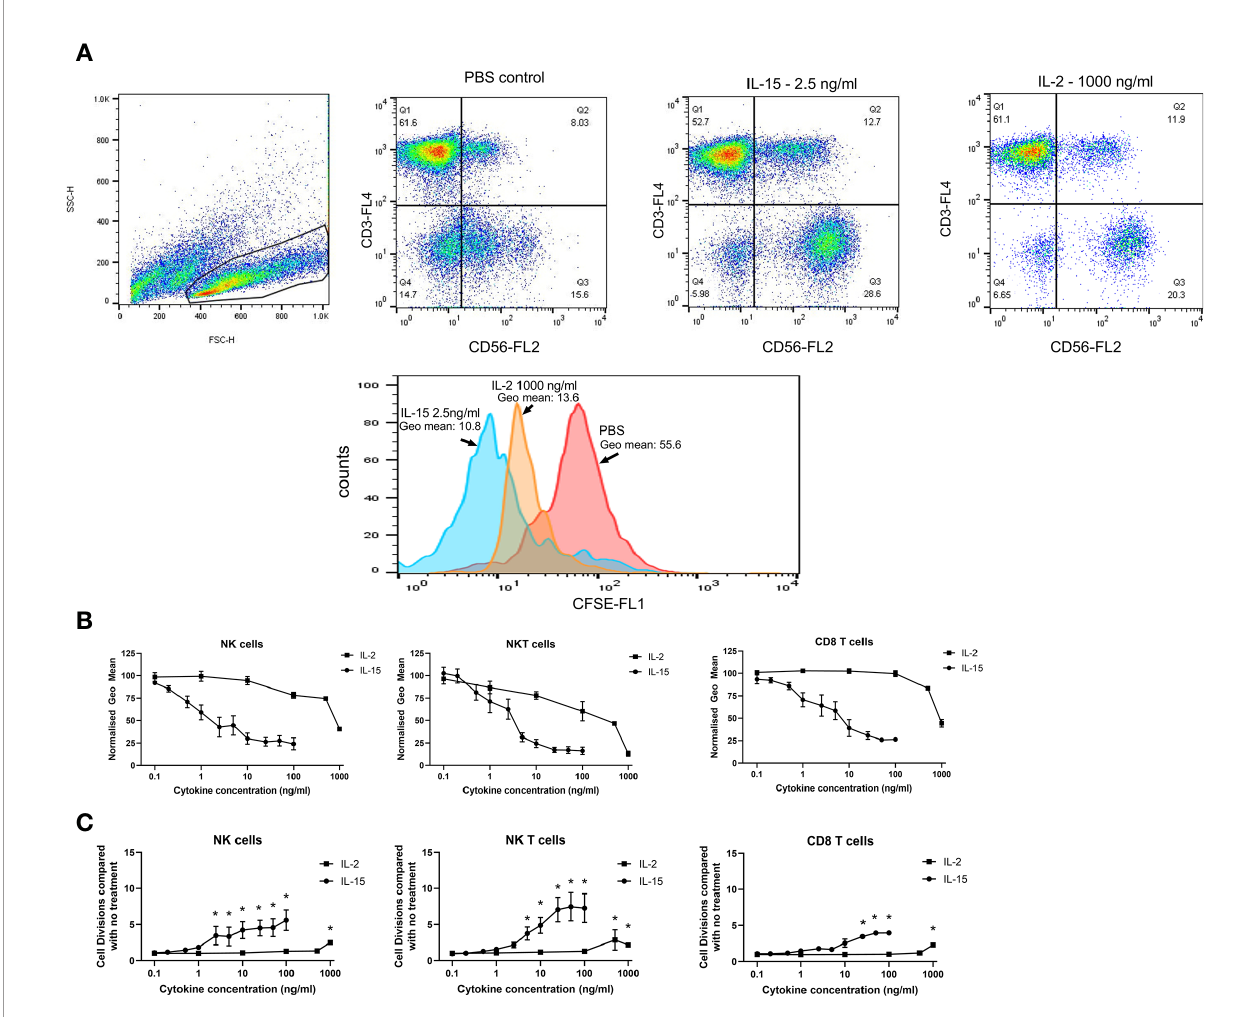
FIGURE 2 | Effects of IL-15 and IL-2 on cell doubling capacity. Non-adherent PBMCs premixed with CFSE were treated for 7 days with concentrations of IL-15 from 0.1 – 100 ng/ml and IL-2 from 0.1 to 1000 ng/ml with PBS as a control. (A) displays the dot plots and a representative histogram showing the representative CFSE staining of a population of CD56+CD3- NK cells in the PBMCs. CFSE staining is measured as the geometric mean of the gated NK cell population and a decrease in the geometric mean signi fi es an increase in cell division. (B) shows the effects of IL-15 and IL-2 on NK, NKT-like and CD8 T cell proliferation as expressed by the normalized geometric mean fl uorescence of CFSE after 7 days. (C) shows the number of cell divisions observed above that of the control cell population (with no cytokines). The numbers of cell divisions were calculated from the geometric mean fl uorescence intensity of the cells by using 1 cell division as equivalent to a 50% decrease in the geometric mean of CFSE. Results represent means ± SEM from six separate experiments (* p < 0.05 by one-way ANOVA and Newman Keuls post-hoc